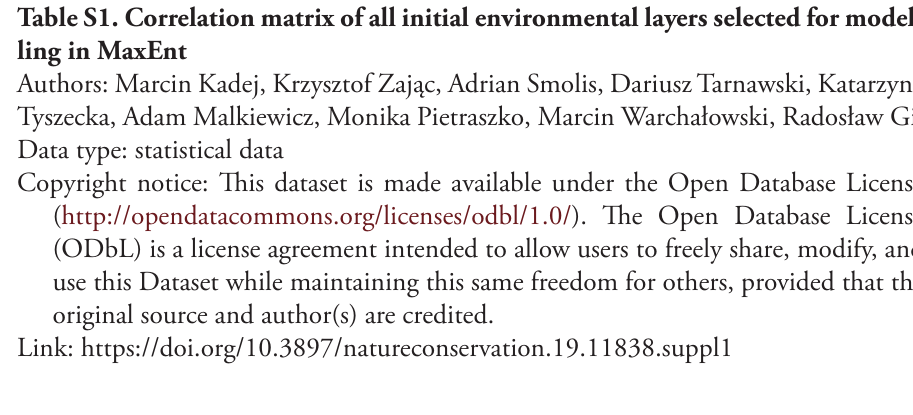
Table S1. Correlation matrix of all initial environmental layers selected for